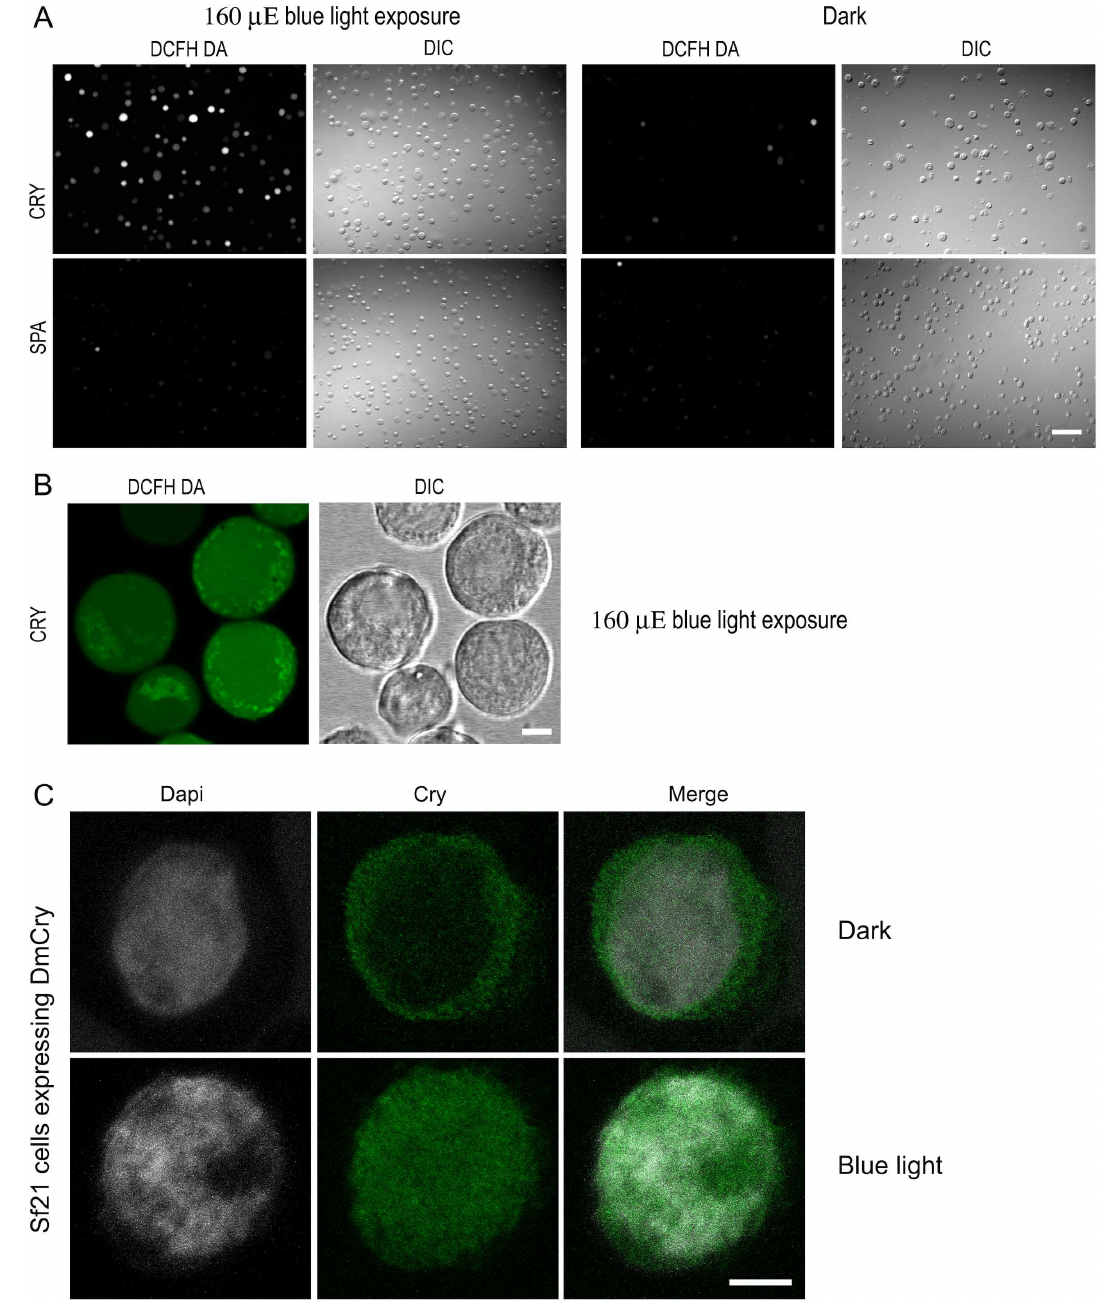
Fig 5. Subcellular localization of ROS and DmCRY in Sf21 insect cells exposed to blue light. Living Sf21 cells stably expressingDmCRY were treated with DCFH-DA, exposedto dark or blue light and viewedby (A) a Zeiss AxioImager.Z1/ ApoTome using a 10x objective(bar 100 μ m) (B) an inverted Leica TCS SP5 microscope. Images show single confocalz section that cross the nucleus.Diffused fluorescent ROS staining can be seen in nucleusand cytoplasm. Punctuateand intense fluorescent ROS staining also colocalizes perfectly with ER (endoplasmic reticulum)surroundingthe nucleus.Scale bar: 10 μ m. (C) Sf21 stably expressingDmCry were fixed with paraformaldehyde,permeabilizedwith Triton X100, incubated with an anti—DmCry1 rabbit polyclonalantibody and an Alexa 488—conjugatedanti—rabbit secondary antibody, DNA were stained with 4 0 ,6 0 — diamino—2—phenylindole(DAPI). Cells were observedwith a Leica TCS SP5 confocal microscope. Images show projectionsof optical sectionsthat cross the nucleus.Scale bar, 10 μ m.